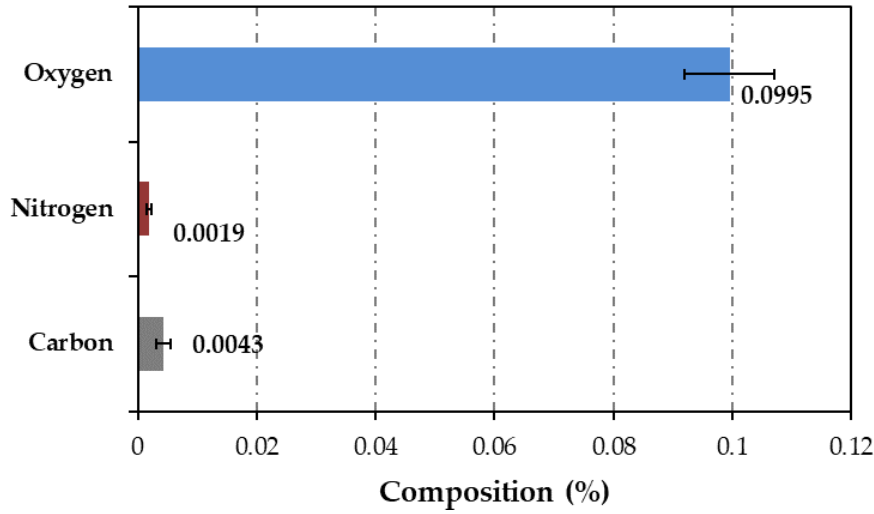
Figure 10. Chemical analysis of carbon, nitrogen and oxygen carried out by LECO for samples com- pacted and sintered at 500 MPa and 835